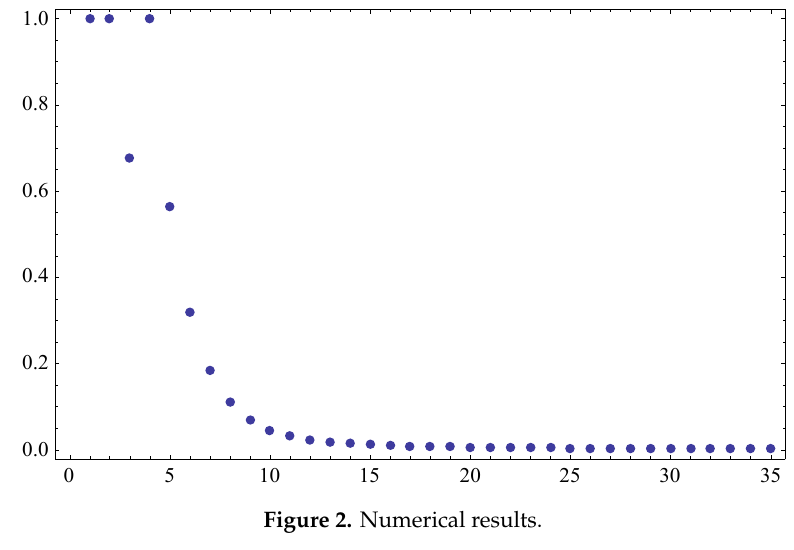
Figure 2. Numerical results.